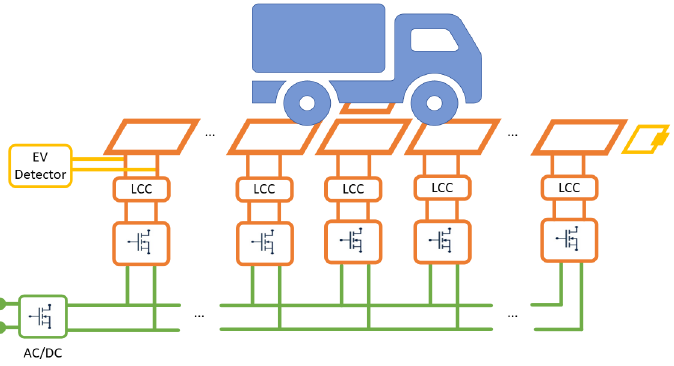
Figure 1. Schematic of a dynamic IPT system. The EV Detector block implements the proposed algorithm and carries out the impedance measurement at the coil terminals.